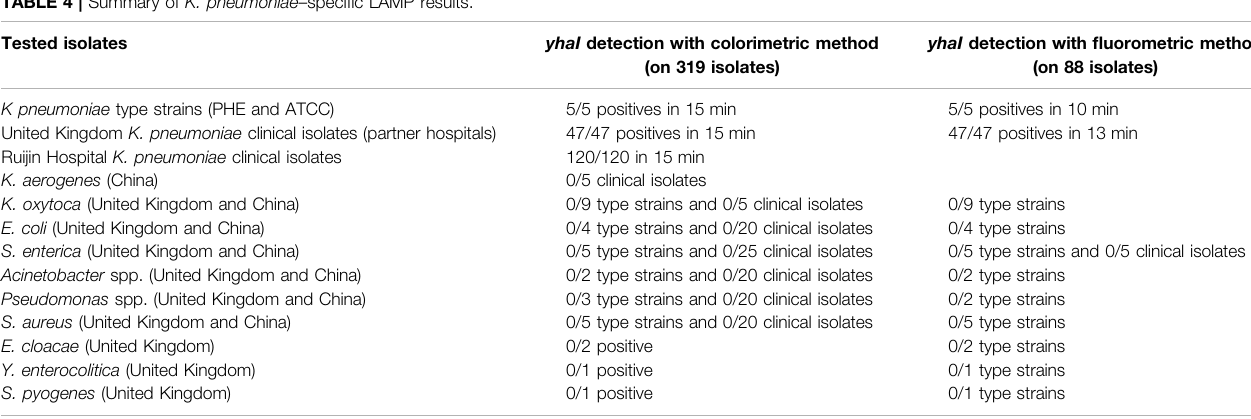
TABLE 4 | Summary of K. pneumoniae – speci fi c LAMP results. Tested